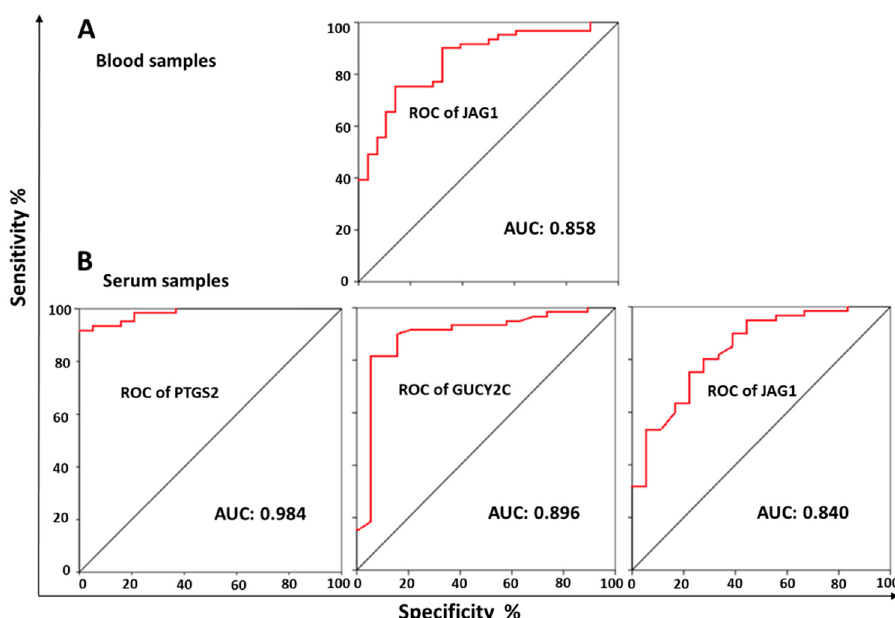
Figure 4. Receiver operating characteristic (ROC) curves analysis. The area under the ROC curve (AUC) with 95% of confidence intervals (CIs) was obtained to evaluate the diagnostic accuracy of individual blood-derived circulating mRNAs of JAG1 ( A ) and individual serum-derived circulating mRNAs of PTGS2 , GUCY2C and JAG1 ( B ).